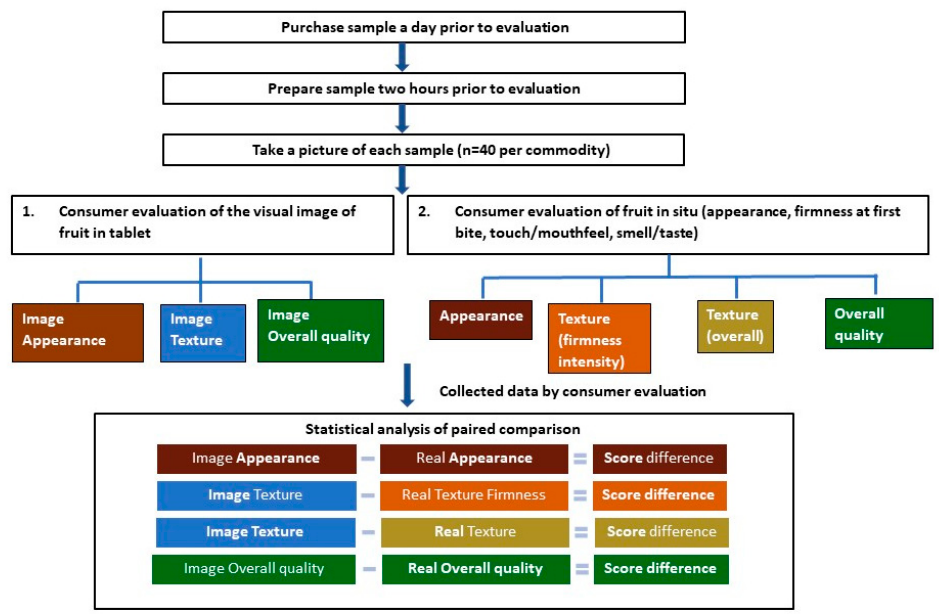
Figure 1. The concept and process map of consumer’s visual perception of real fresh produce vs. its digital image.